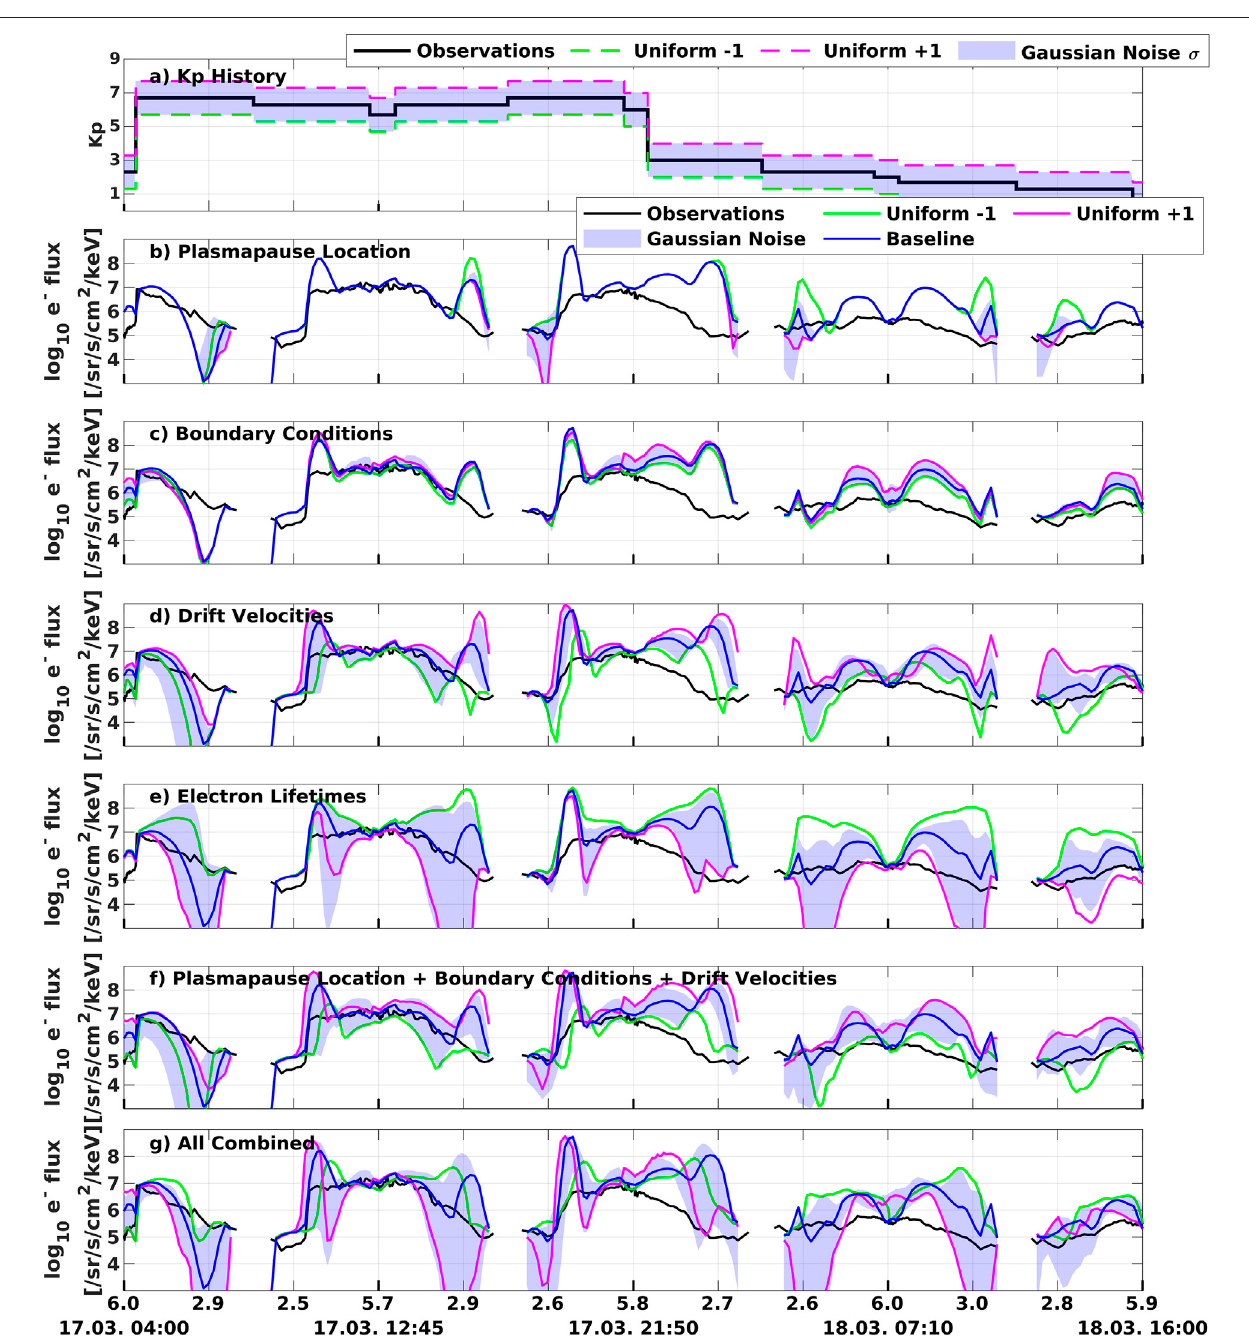
FIGURE2 | Perturbation results of10 keV electron fl uxand 54 ° local pitch-angle at thespacecraft ’ slocationfor the intenseeventalongtheRBSP-Borbit. Theblue areasshowtherange ofsimulation results, whenKpisperturbedusing Gaussian noise.Theblacklineinpanels b – gshows theRBSP-B fl ux data. (A) OriginalKphistory andperturbedones. (B) Perturbingplasmapauselocationmodel. (C) Perturbingboundaryconditionmodel. (D) Perturbingdriftvelocities. (E) Perturbingelectronlifetime models. (F) Perturbing plasmapause location, boundary conditions and drift velocities combined. (G) Perturbing all processes combined.